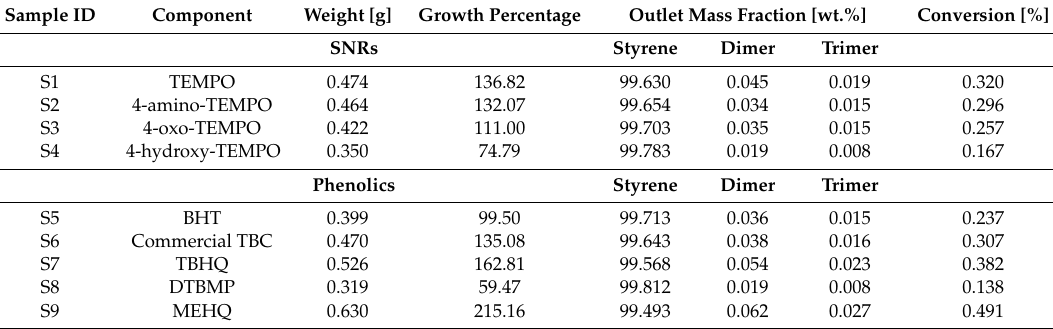
Table 4. Measured weights of polymer and the growth percentage in the presence of inhibitors after 8